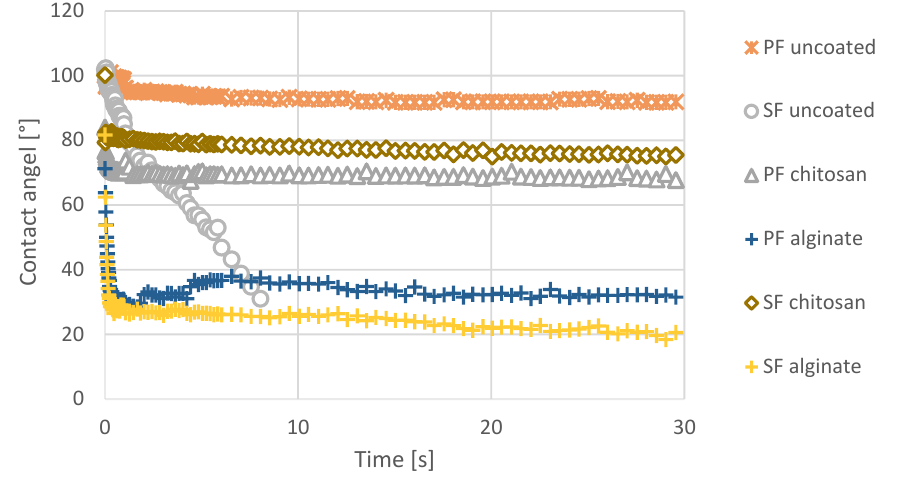
Figure 4. Contact angle of uncoated and coated samples measured with deionized water for 30 s ( n = 6).